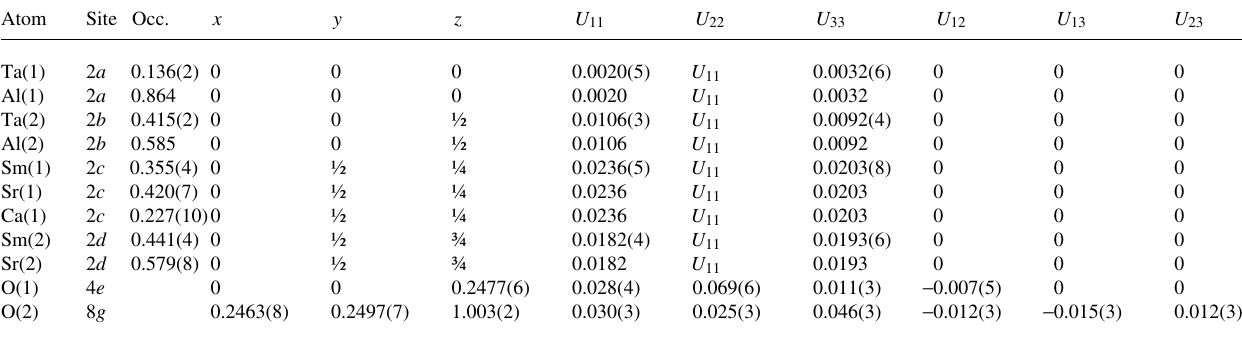
Table 2. Atomic coordinates and displacement parameters (in Å 2 ) .